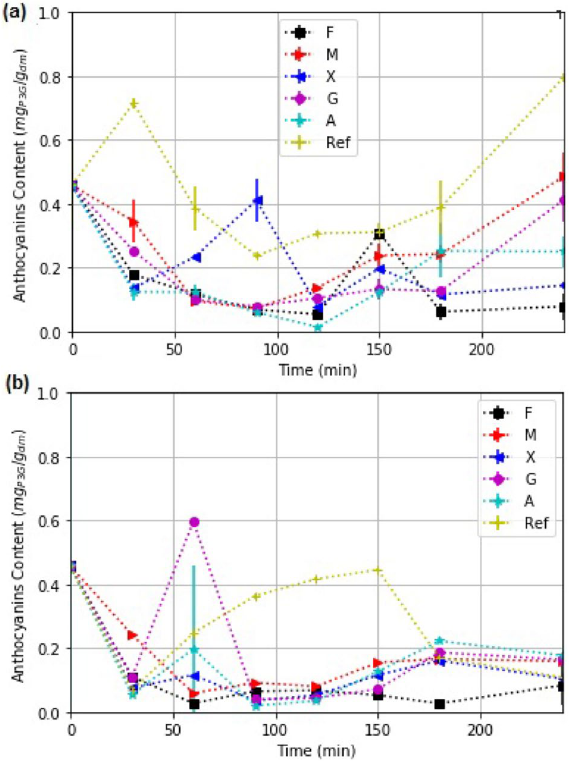
Figure 9. Kinetics of total anthocyanin content for strawberry slices with edible coatings (A–F) and for the reference slices without such coating under: ( a ) solar drying and ( b )